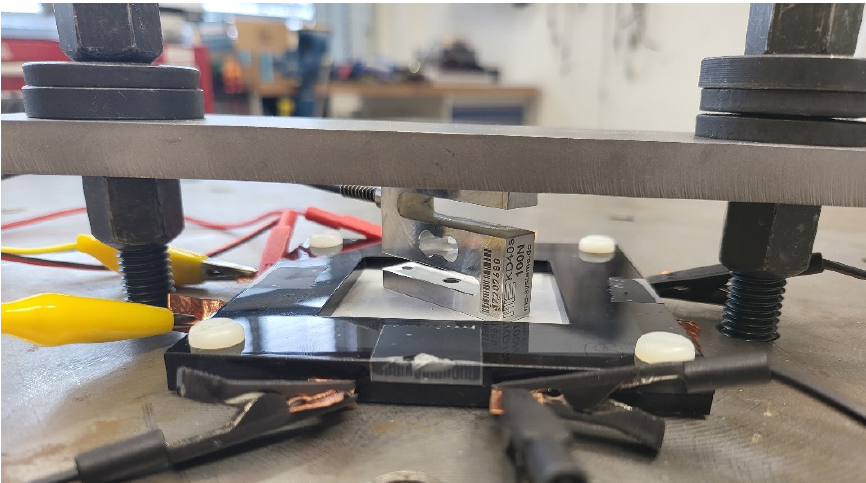
Figure 7. Measurement setup for the blocking force.